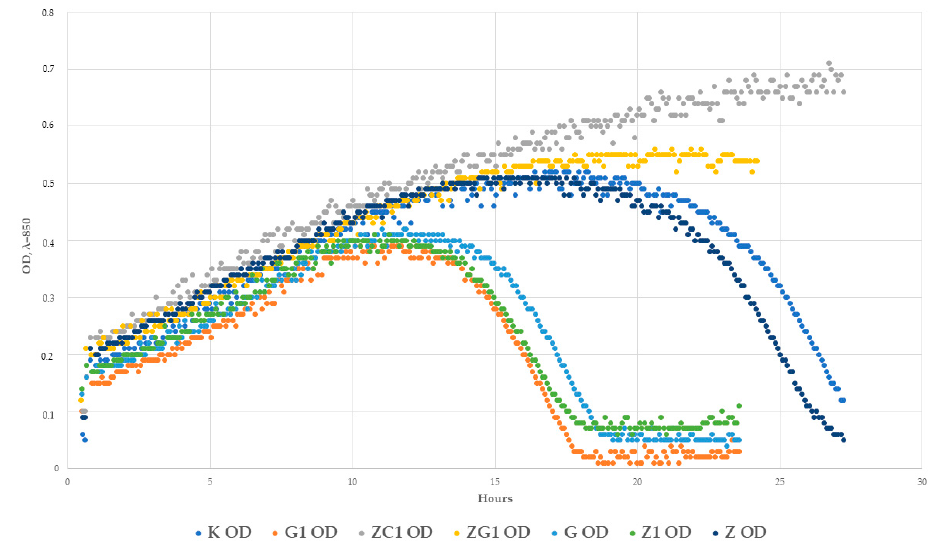
Figure 7. OD over time for P. syringe after 30 h of incubation. Incubation with phi 6 phages after their incubation with the chosen coatings; addition of phages when OD—0.2; amount of phage MOI—1.